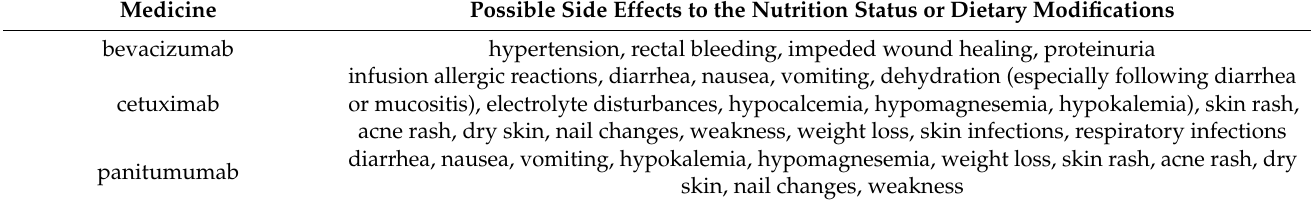
Table 2. Side effects of biological drugs (recombinant monoclonal bodies) with can have a negative impact on the nutrition status